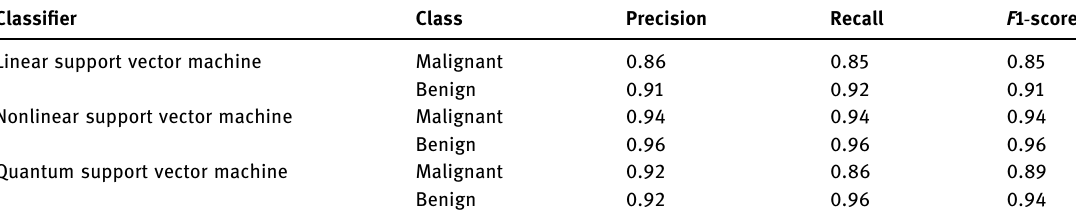
Figure 7: Visualizing classi fi cation achieved by quantum SVM: ( a ) predicted labels on ( b ) test set for the fi rst fold during cross - Table 4: Precision, recall, and F 1 - score for the three SVM variants Classi fi er Class